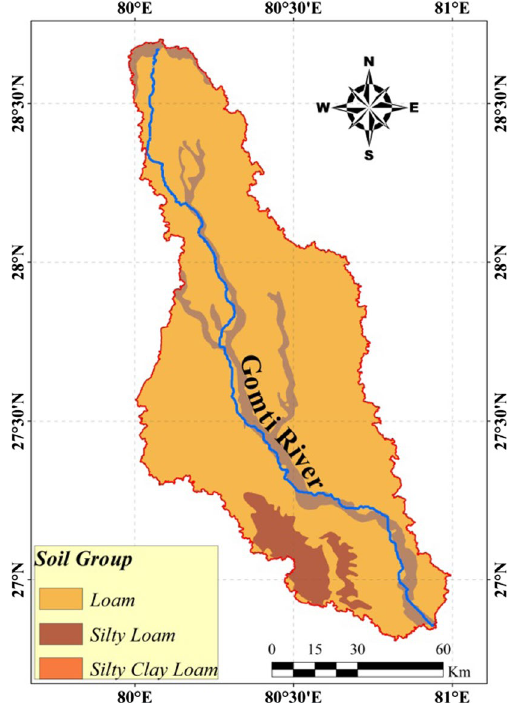
Fig. 4 Soil map the study area